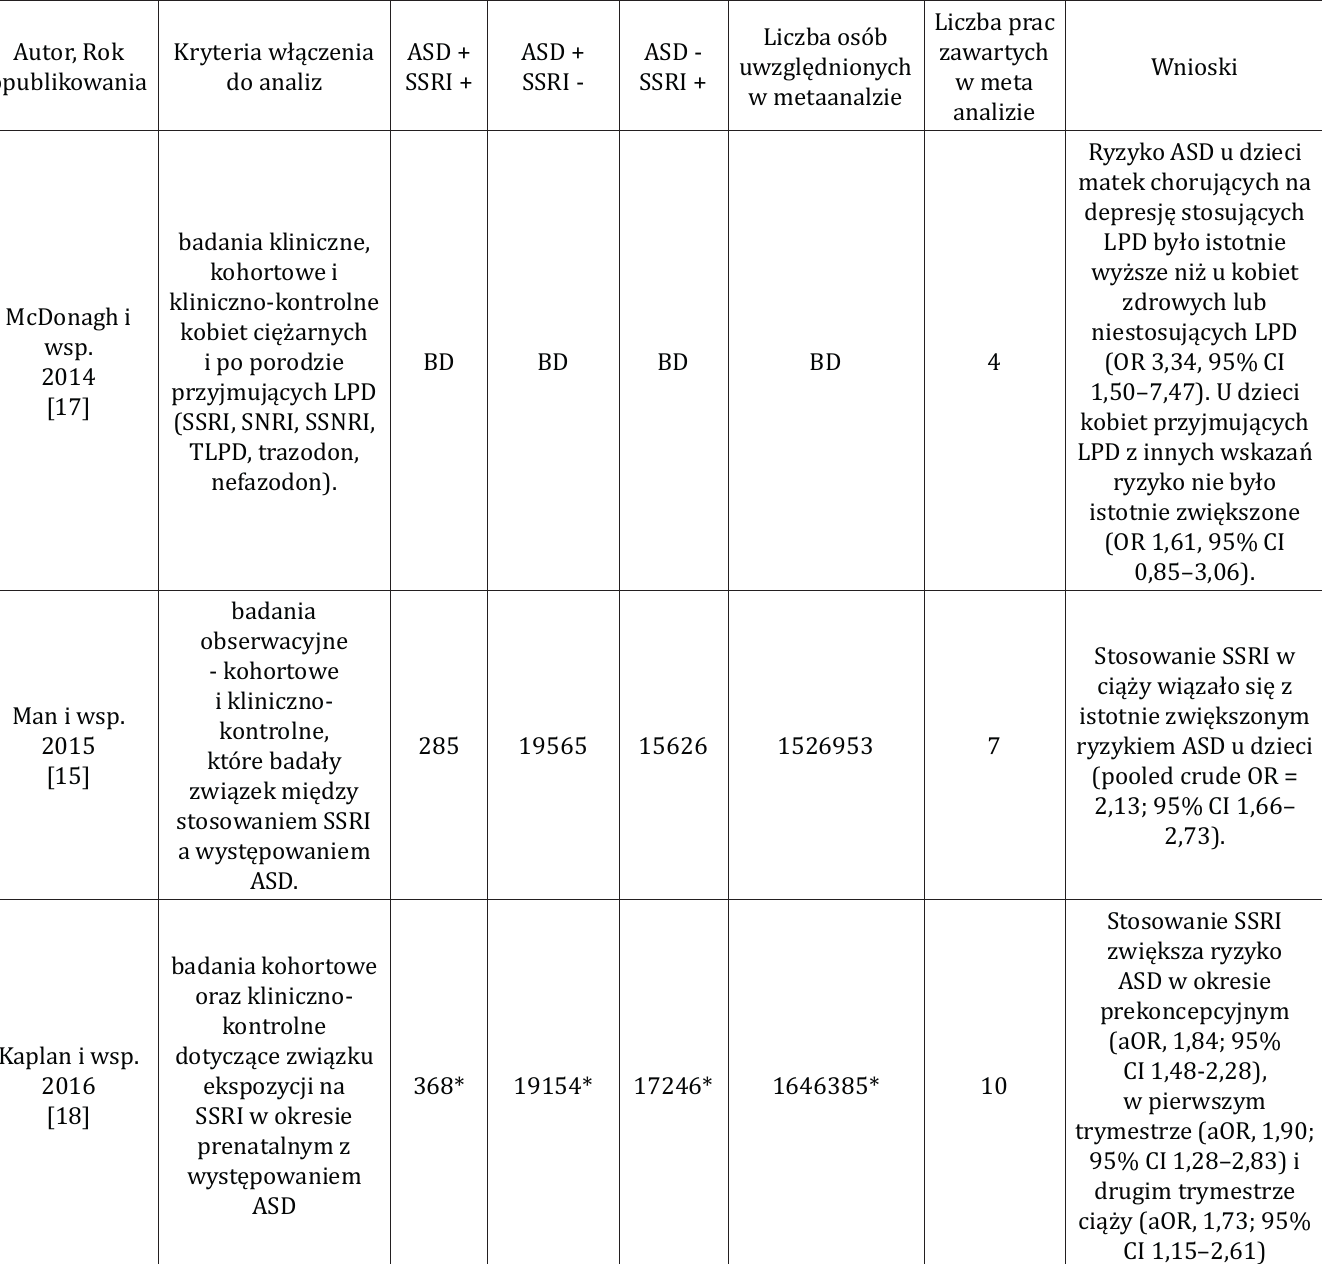
Tab. 1. Porównanie meta-analiz dotyczących związku między prenatalnym narażeniem na SSRI a zaburzeniami ze spektrum